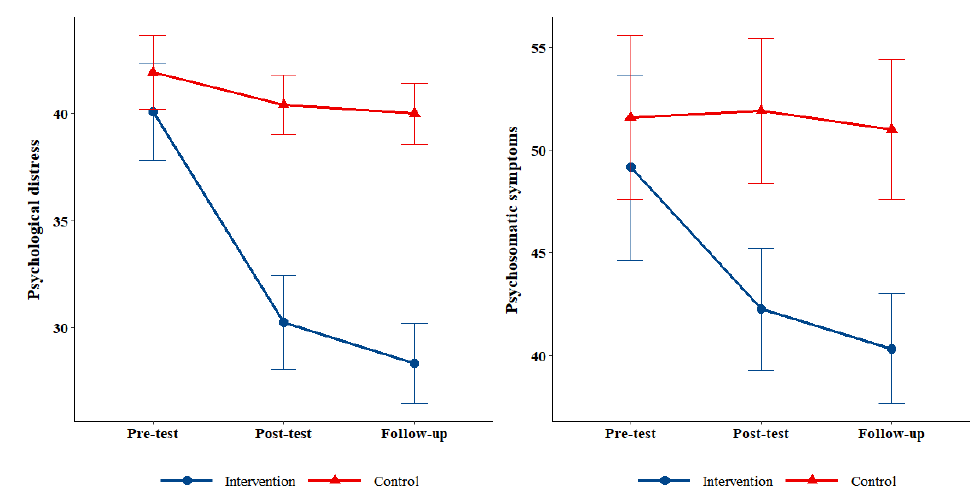
Figure 1. The line plot of psychological distress and psychological symptoms based on time and group.